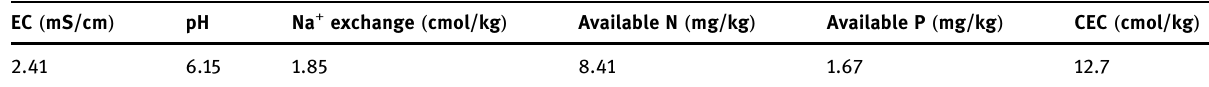
Table 3: Some soil properties before the